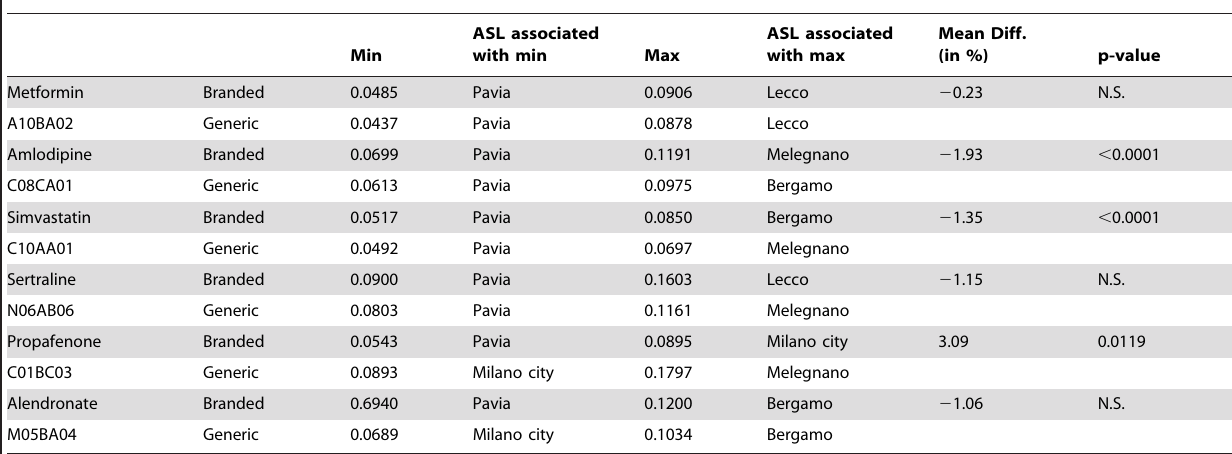
Table 6. Percentage of deceased among persistent patients.